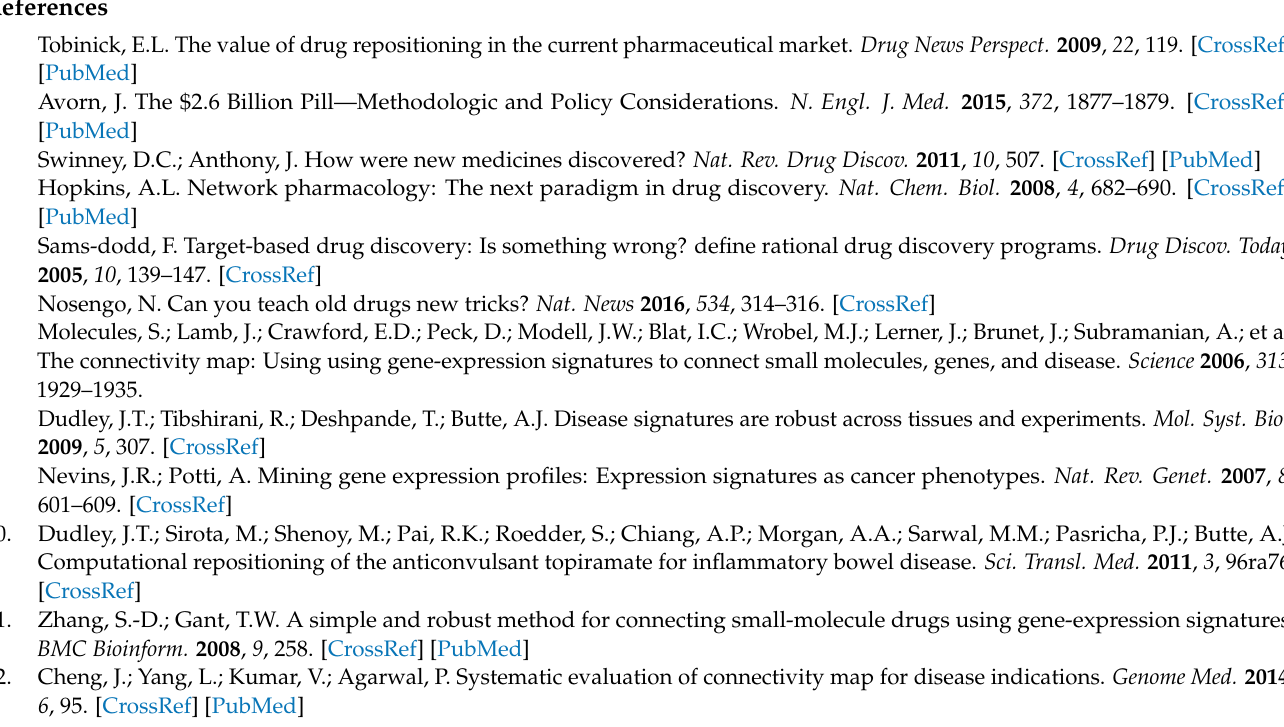
Figure S2—Expression signal strengths of all compound expression profiles on five cell lines. Sup- plementary Figure S3—Module Interaction Network Based on PPI. Supplementary Figure S4—The performance of MNBDR with different parameters. Supplementary Figure S5—Performance of Drug–disease association prediction with top n modules as important modules ( λ = 0.85). Supple- mentary Figure S6—The performance of our method using 10-fold cross validation. Supplementary Table S1—Drug-Indication relationships (benchmark standard). Supplementary Table S2—The genes involved in the Modules. Supplementary Table S3—The results of each cancer type. Supplemen- tary Table S4—Functional annotation of module genes. Supplementary Table S5—The score of disease-drug